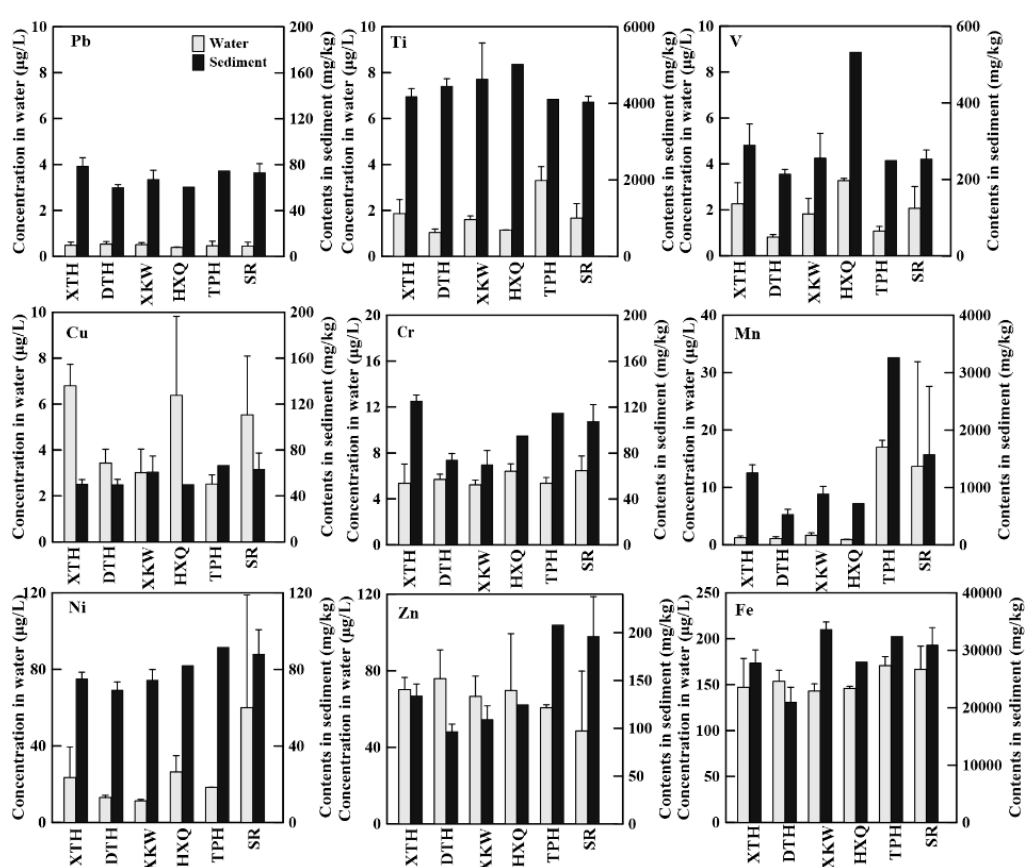
Figure 2. Heavy metal concentrations in water and surface sediments from Taihu Lake and rivers: Xukou bay (XKW), Western Taihu Lake (XTH), Eastern Taihu Lake (DTH), Central Taihu Lake (HXQ), Taipu River (TPH), Surrounding Rivers (SR), error bars represent SD. Captions are the same in the following figures.